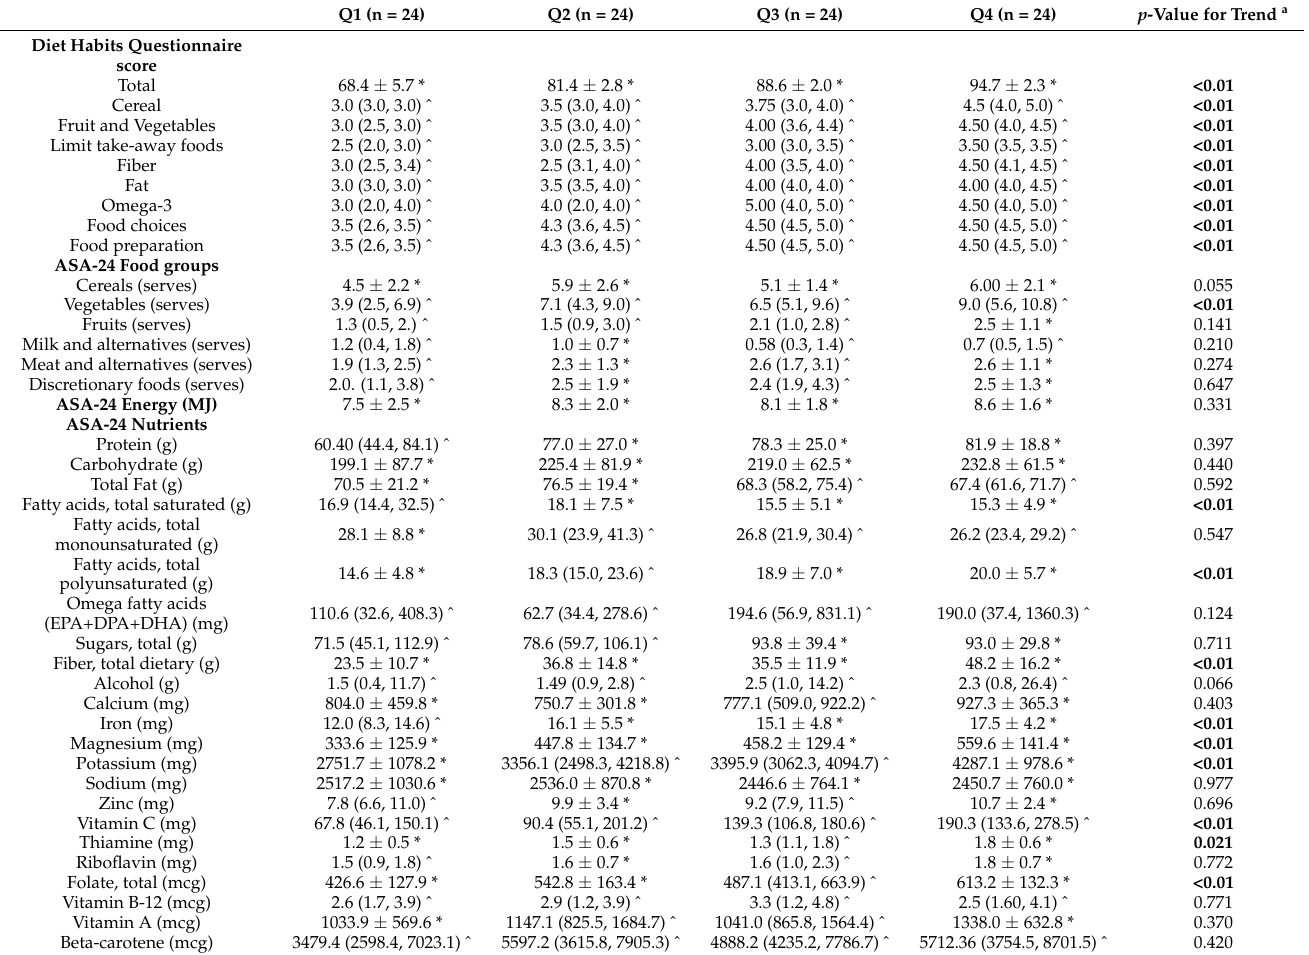
Table 3. Usual daily dietary intake by quartiles of Diet Habit